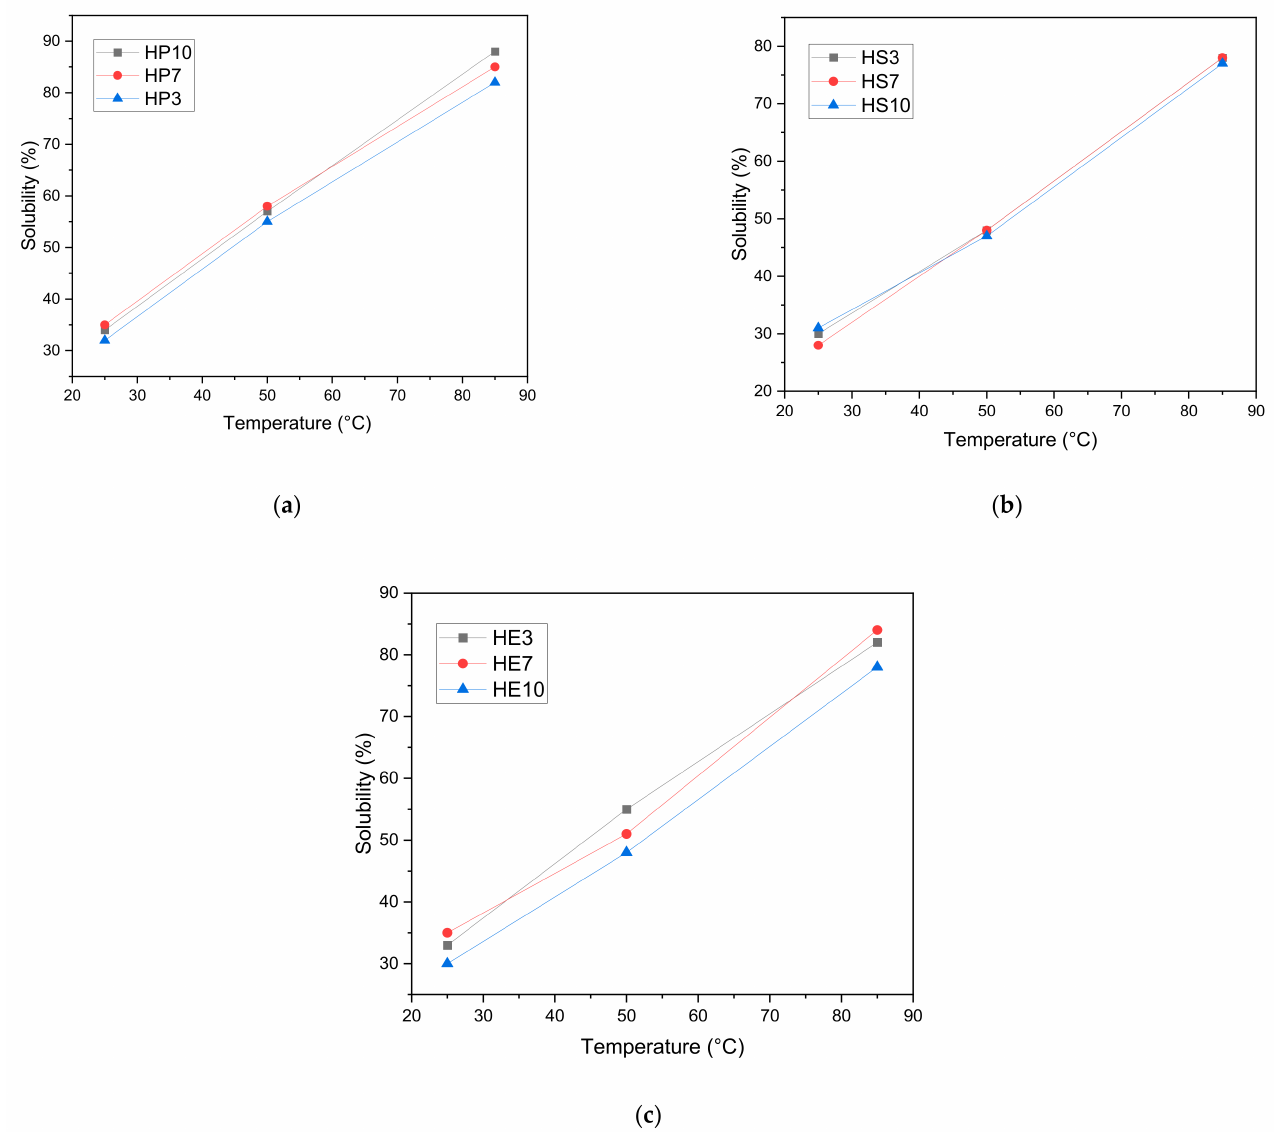
Figure 3. Sample solubility as a function of temperature from ( a ) Pulp; ( b ) Seed; ( c ).